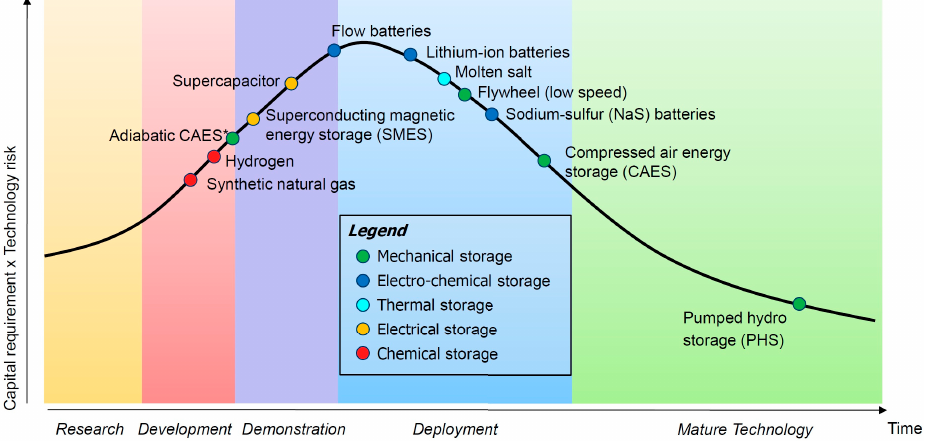
Figure 1. Maturity of energy storage technologies [14].